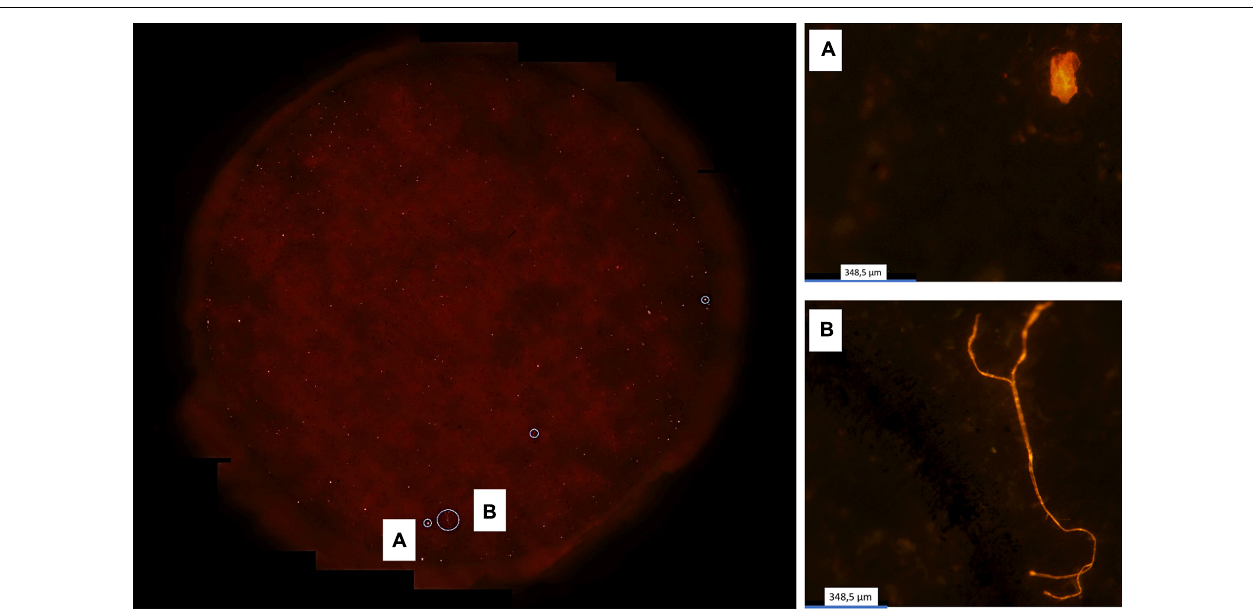
FIGURE 5 | Nile red imaging analysis of pooled sample 2 of Pleuronectes platessa from UKNS with identification of two particles identified as plastic, larger than 120 µ m.